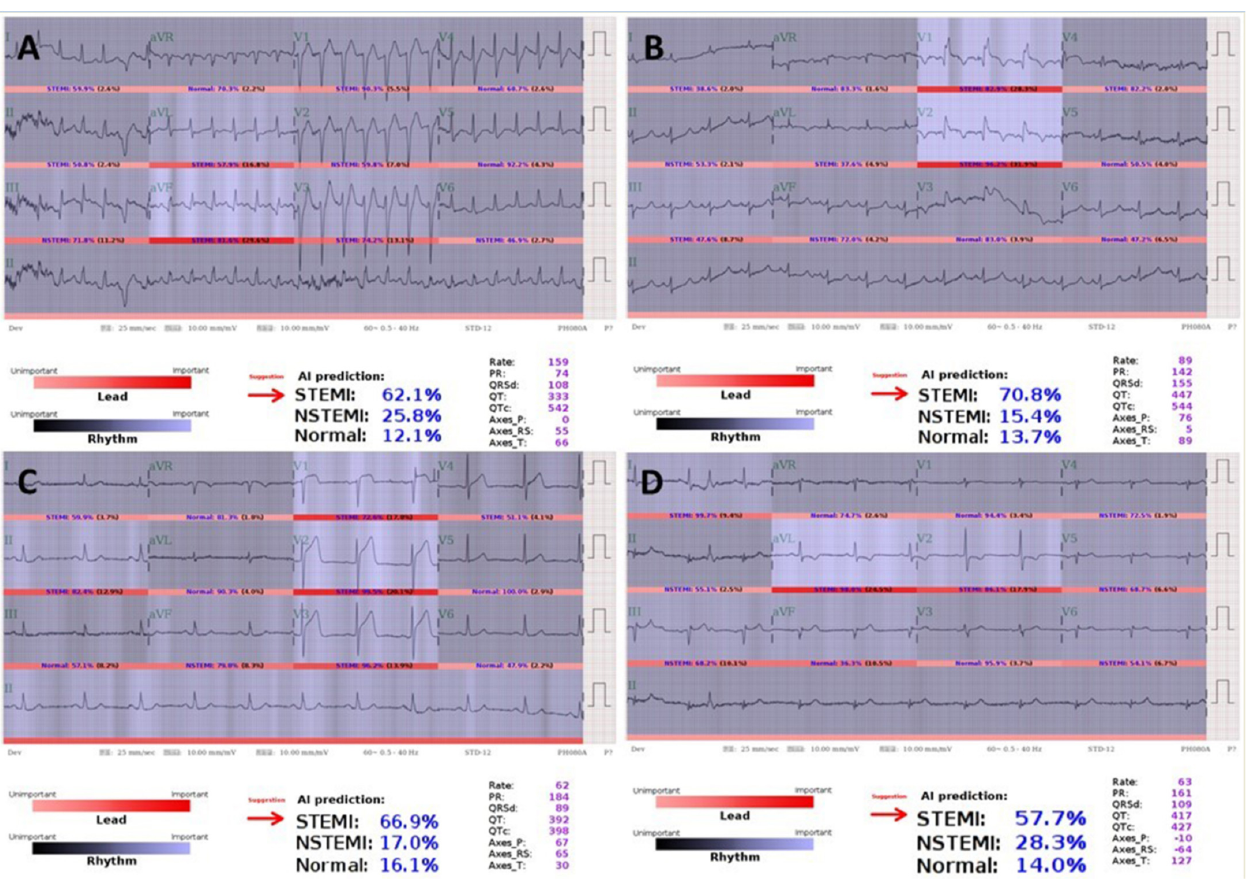
Figure 2. STEMIs for which alarms failed to be raised by the AI-based alarm strategy. ( A , B ) are both post-resuscitation ECGs with STEMI prediction scores of 62.1% and 70.8%, respectively. ( C ) Hyperacute T presentation with prompt initiation of PPCI with a STEMI prediction score of 66.9%. ( D ) Inferior wall STEMI with deep Q in III, aVF and reciprocal ST-T change in I, aVL, V2 with STEMI prediction score of